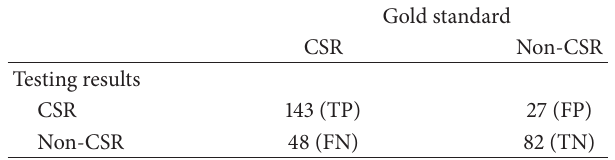
Table 3: Evaluation about CSR.